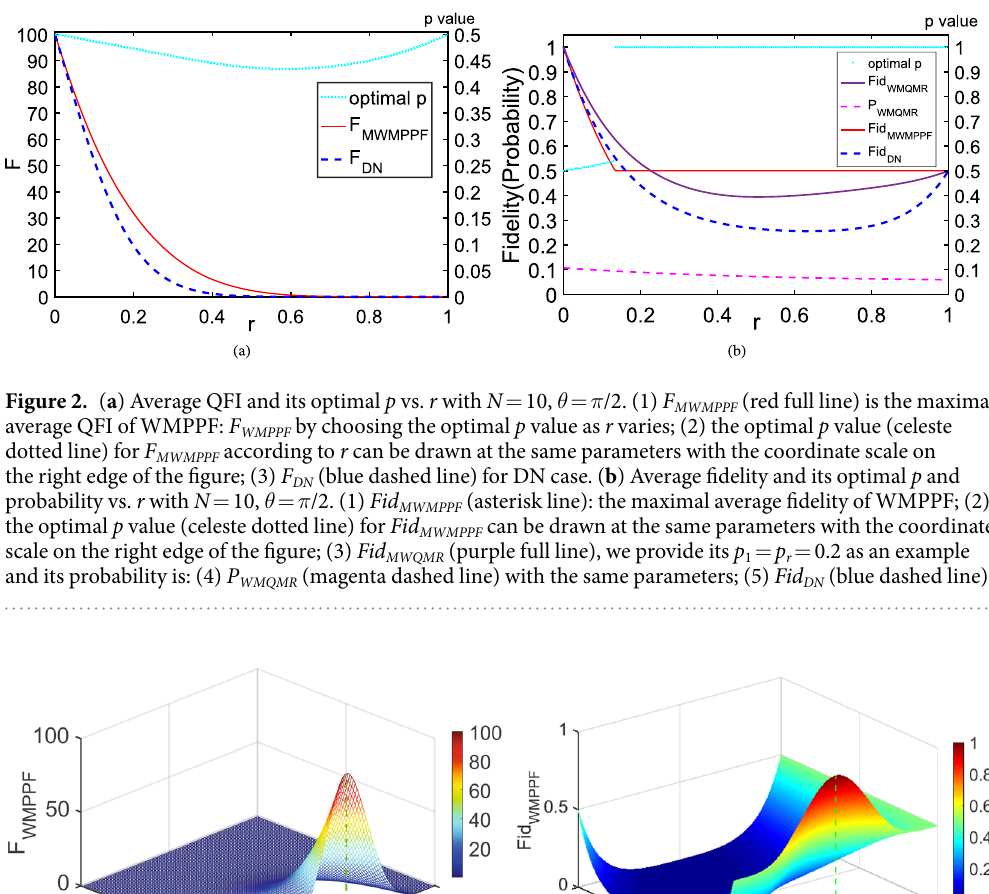
for all r in [0, 1] , which has been mentioned already. Figure 2(b) shows average fidelity vs. r for the same situation with Fig. 2(a). From it, Fid MWMPPF (we call Fid MWMPPF the maximal average fidelity of Fid WMPPF , which depends on different optimized p on different r ) are not always larger than Fid DN . For Fid WMQMR , we provide p 1 = p r = 0.2 as an example. Contrasting (a) with (b) on the same r infers that: the WMPPF can protect the average QFI but this scheme can not protect fidelity very well even for MWMPPF, and WMQMR can protect the average fidelity but can not protect the average QFI at all. So for WMPPF or for WMQMR, a scheme protecting the average fidelity of GHZ state does not necessarily protect the average QFI of it and vice versa. In Fig. 3(a) we give the average QFI of WMPPF vs. p and r with N = 10, θ = π /2. In Fig. 3(b), we give the average fidelity of WMPPF vs. p and r with the same parameters as Fig. 3(a). From them we can see that F MWMPPF and Fid MWMPPF depends different optimized p with different r > 0, which are the maximal average QFI of the WMPPF F WMPPF and the maximal average fidelity of the WMPPF Fid WMPPF corresponding to the ridge lines of the two figures respectively. And the two p - r -plane projection lines of these two ridge lines are just the p value curves in Fig. 2(a,b) respectively. It is clear that p = 0.5 is the optimal value for both F MWMPPF and Fid MWMPPF at r = 0 (i.e., 100 and 1 separately), while the optimal p values for F MWMPPF and for Fid MWMPPF are different and they both deviated from 0.5 when r > 0. And the two figures depict that their maximal values evolving with r > 0 are very different, respectively. In Fig. 3(b) when r changes to 0.134 where the optimal p of the average fidelity is 0.538 and the maximal average fidelity is 0.5005. However, when r = 0.135 or larger than it, the maximal average